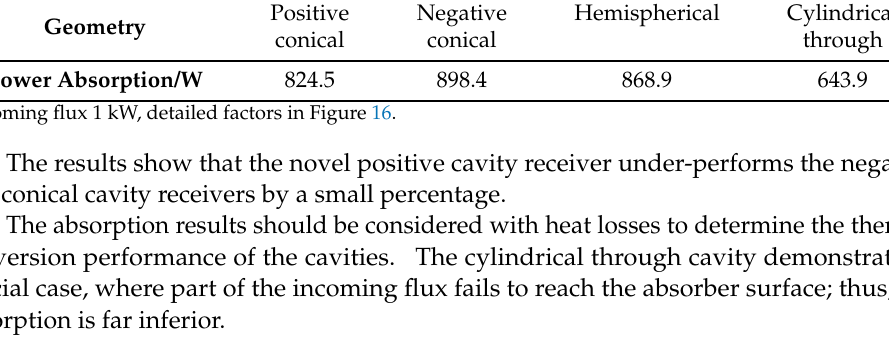
Table 4. Power absorption for different geometries (ray tracing) *. Positive Negative Hemispherical Cylindrical Geometry conical conical through Power Absorption/W 824.5 898.4 868.9